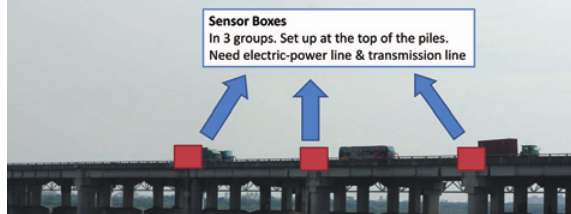
Fig. 5. The deployment diagram of the sensors